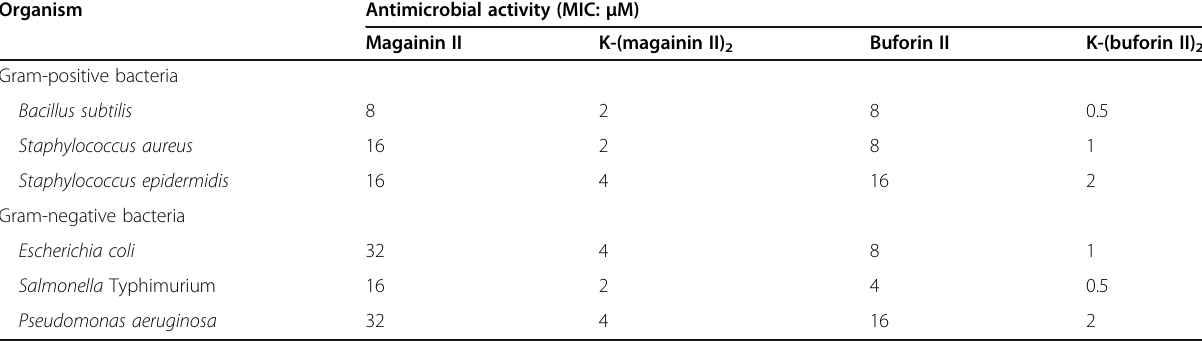
Table 2 Antimicrobial activities of peptides against gram-positive and gram-negative bacteria Organism